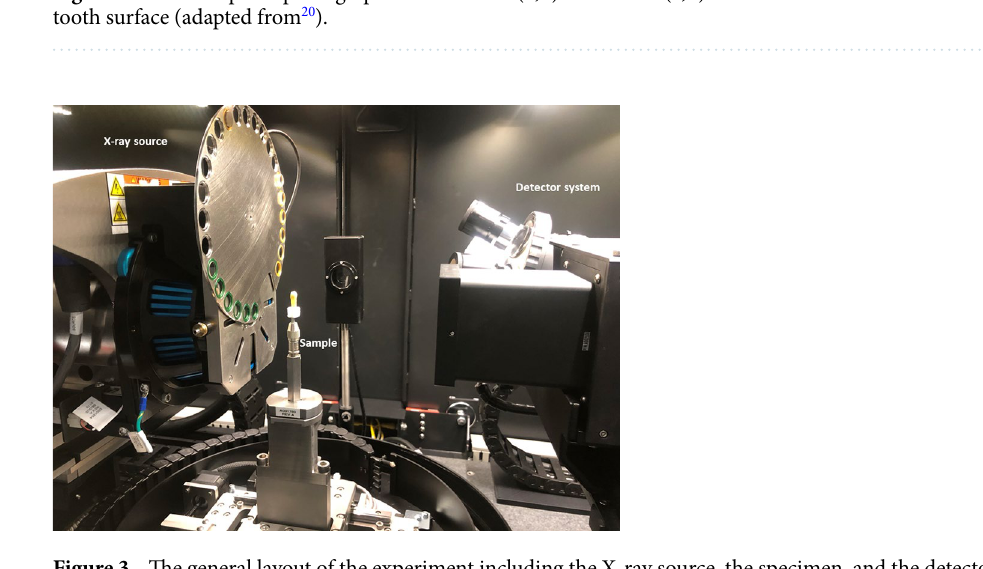
Figure 3. The general layout of the experiment including the X-ray source, the specimen, and the